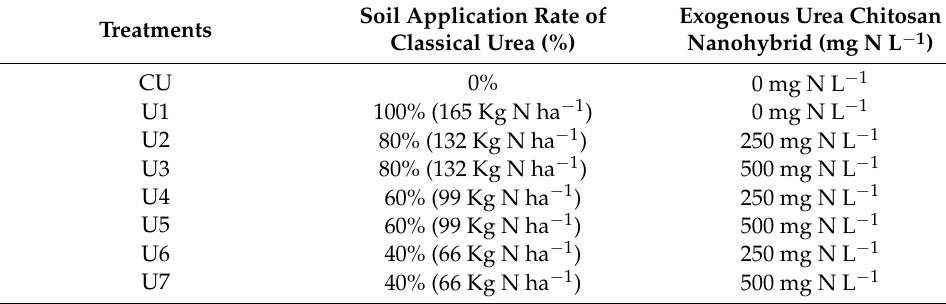
Table 3. The details of the experimental